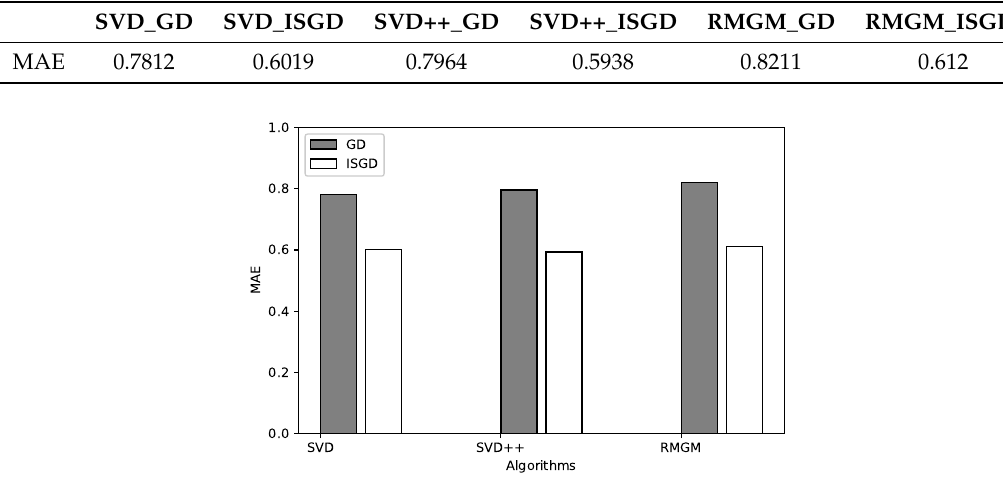
Figure 6. Comparison of MAE with other